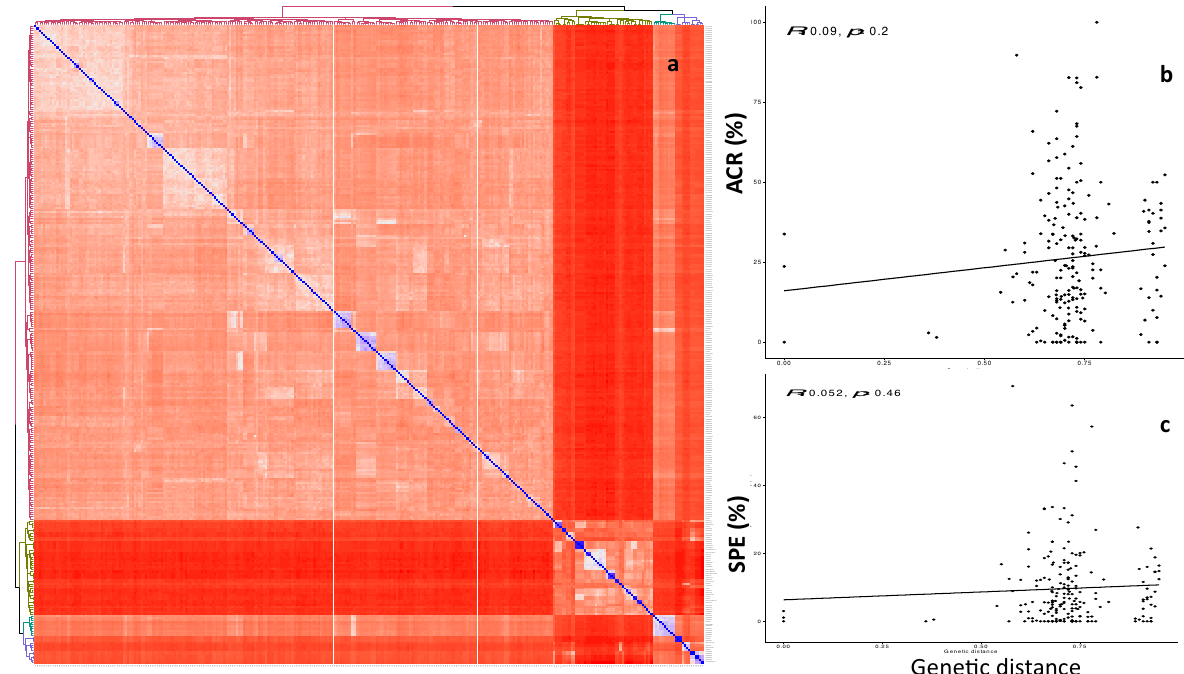
Figure 5. Genetic relatedness among D. rotundata genotypes using SNP information: (a) Heatmap IBS genetic distance, and influence on (b) the average crossability rate (ACR) and (c) seed production efficiency (SPE) in D. rotundata cross-combinations.